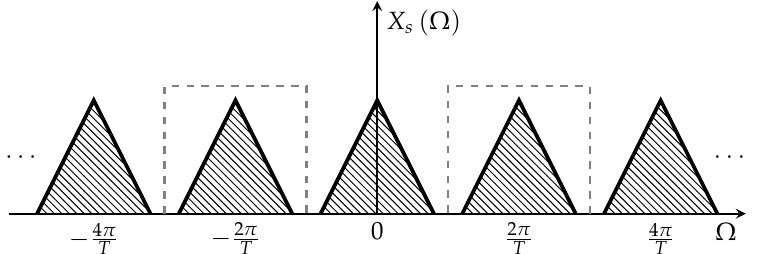
Figure 7. Signal spectrum after impulse modulation. The frequency bands in the dashed box are of interest after sampling in the synchronous mixing architecture.